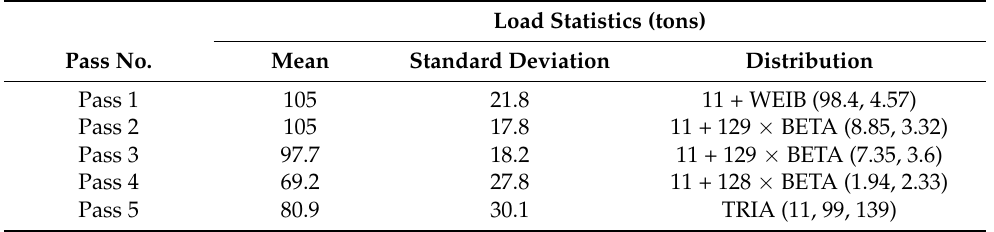
Table 3. Bucket load statistics for the fleet of